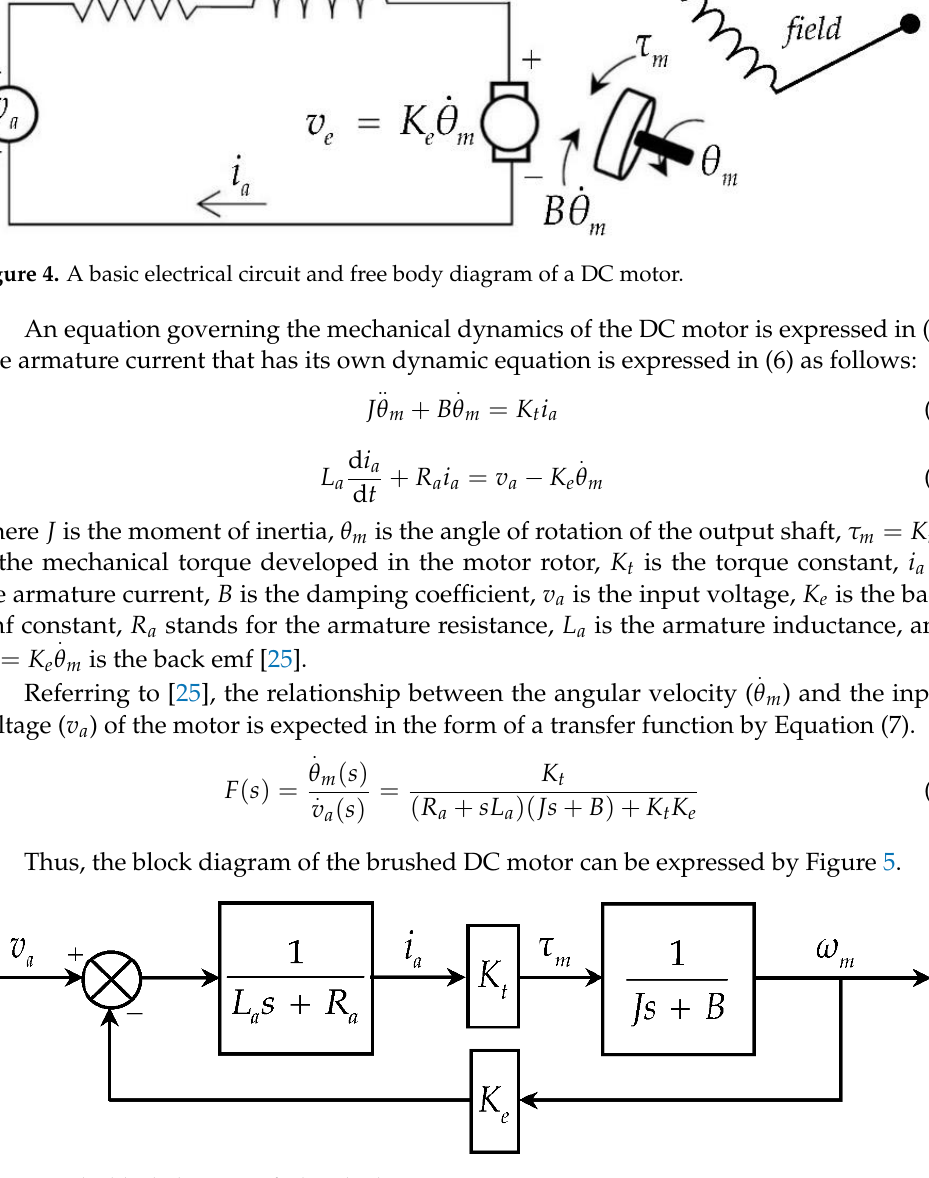
Figure 4. A basic electrical circuit and free body diagram of a DC motor.